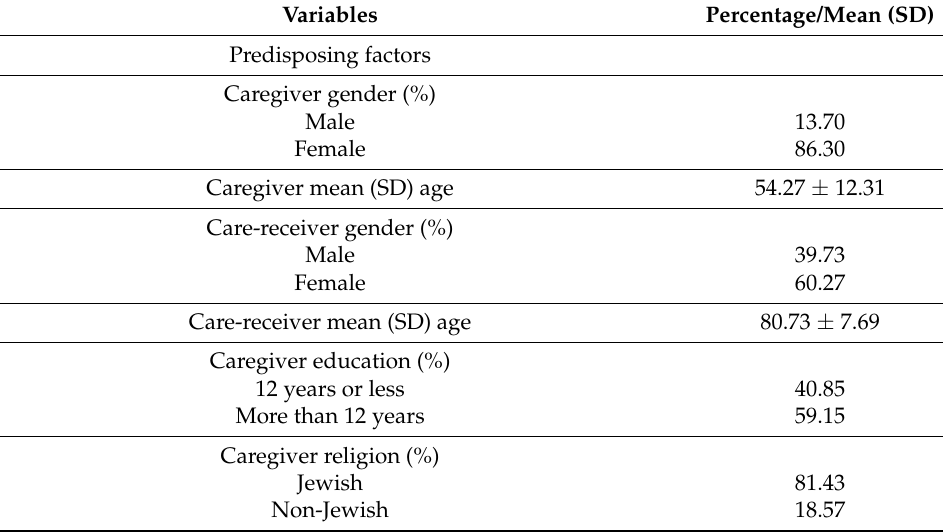
Table 1. Descriptive statistics for independent variables ( n =